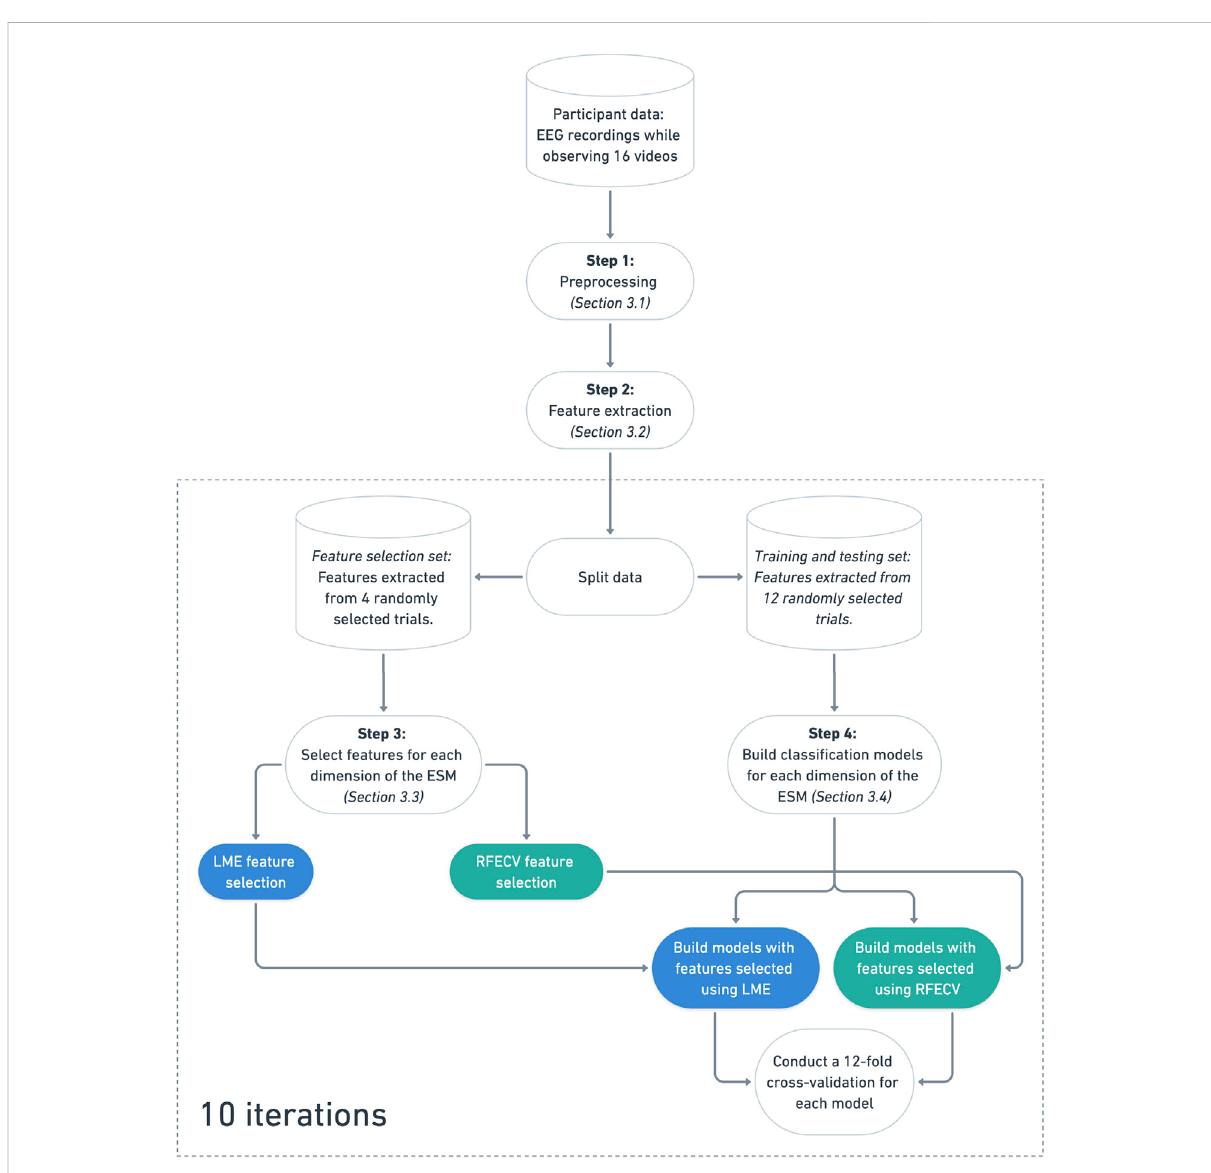
FIGURE 3 Flowchart describing the signal processing steps. Steps 3 and 4 were repeated 10 times for each participant. In each iteration, 4 trials were randomly selected and used for conducting feature selection with LME and RFECV. The remaining 12 trials were used for training and testing the classi fi cation models. A subset of features was selected for each affective dimension of the ESM (Cacioppo et al., 1997) (negativity, positivity, and net predisposition).The featuresselectedwith LMEwereused to build oneclassi fi cation model for each affective dimension. Likewise,